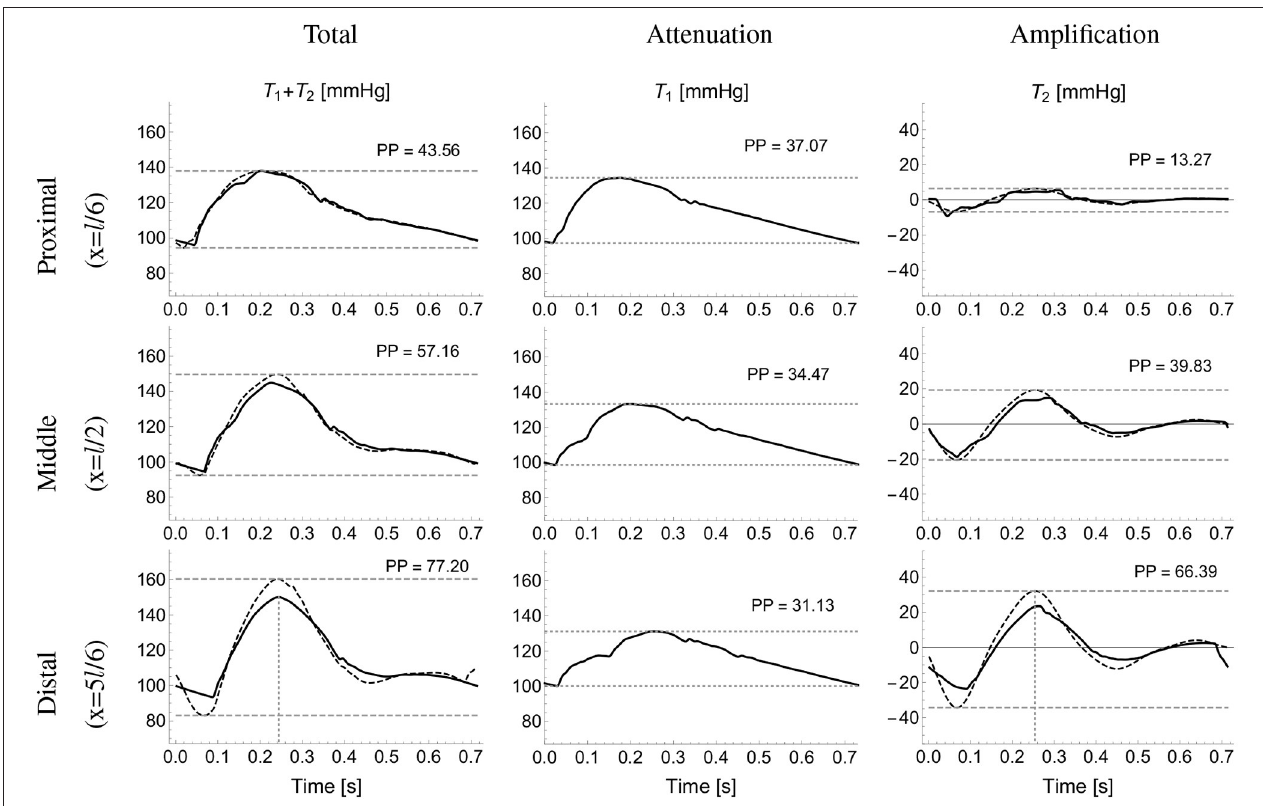
FIGURE 4 | Analytical pressure wave decomposition. The total pressure wave calculated using the reduced model (first column) at proximal (top) , midpoint (middle) , and distal (bottom) sites along the brachial artery was decomposed into the attenuation, T 1 (second column) and amplification, T 2 (third column) terms calculated using the single-vessel model (Equations 2 and 3). The approximated total (sum of Equations 2 and 7) and T 2 pressures (computed using Equation 7) are shown in dotted lines (first and third columns, respectively). Horizontal dashed lines highlight pulse pressure (PP) values. Vertical dashed lines (bottom plots) indicate the time of minimum d Q in / d t